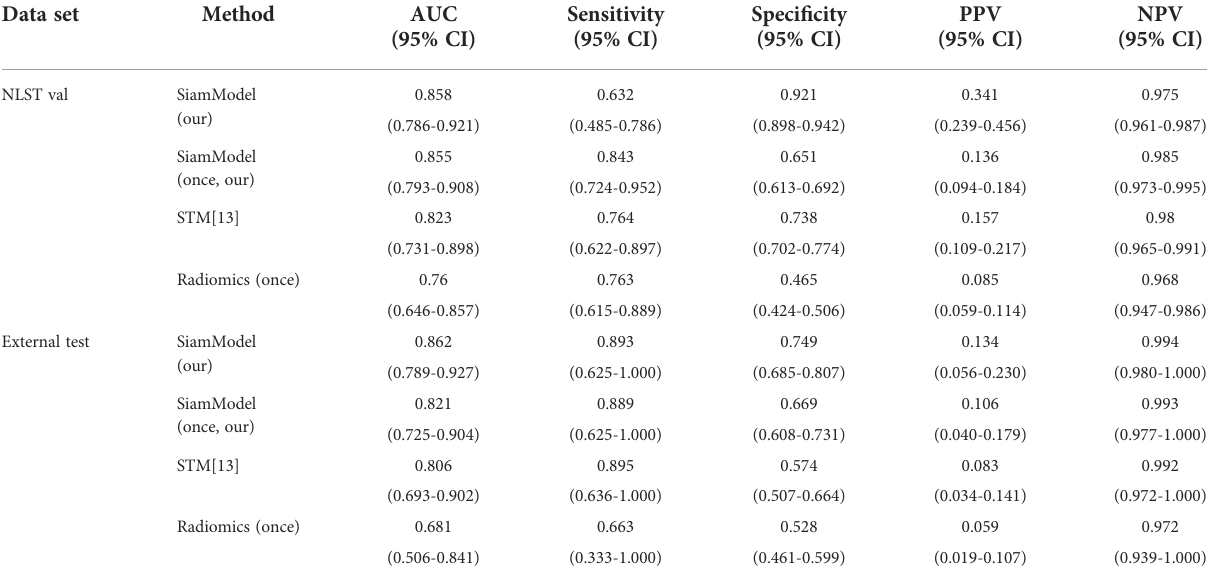
TABLE 3 Performance of different models using only one CT scan in the validation and external test sets.